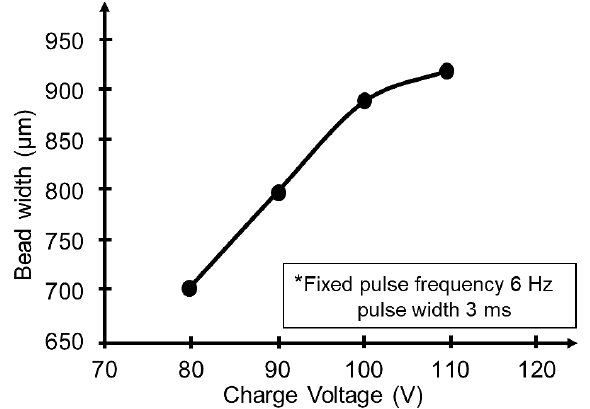
Appl. Sci. 2019 , 9 , x FOR PEER REVIEW Figure 9. E ff ect of charge voltage on weld bead width. Figure 9. Effect of charge voltage on weld bead width. Figure 9. Effect of charge voltage on weld bead width.